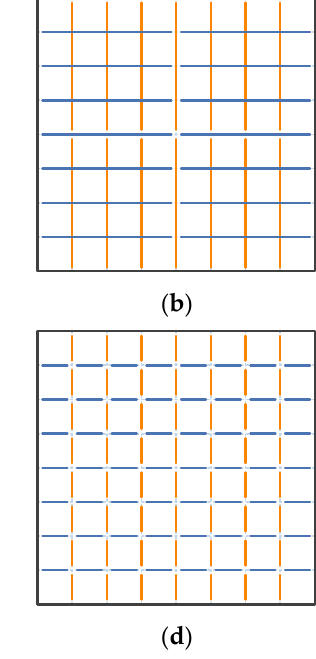
Figure 3. Stage grid map. N is the number of boundaries in the current stage; L is the boundary length in the current stage; Blue and orange represent horizontal and vertical division boundaries, respectively. ( a ) Stage 1, N = 14, L = 32; ( b ) Stage 2, N = 28, L = 16; ( c ) Stage 3, N = 56, L = 8; ( d ) Stage 4, N = 112, L = 4.